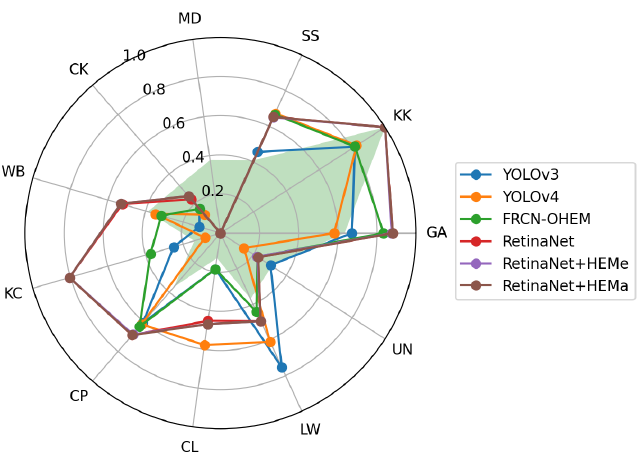
Figure 6. Visual radar map of each category of AP in Table 4. The radius of the radar is the AP for each category, the individual fold lines represent the model as shown in the legend on the right, the categories represented by each orientation are represented at the outermost part of the radar, and the shaded area in the middle of the radar represents the normalized scale of the average pixel size of the bounding box for each category.